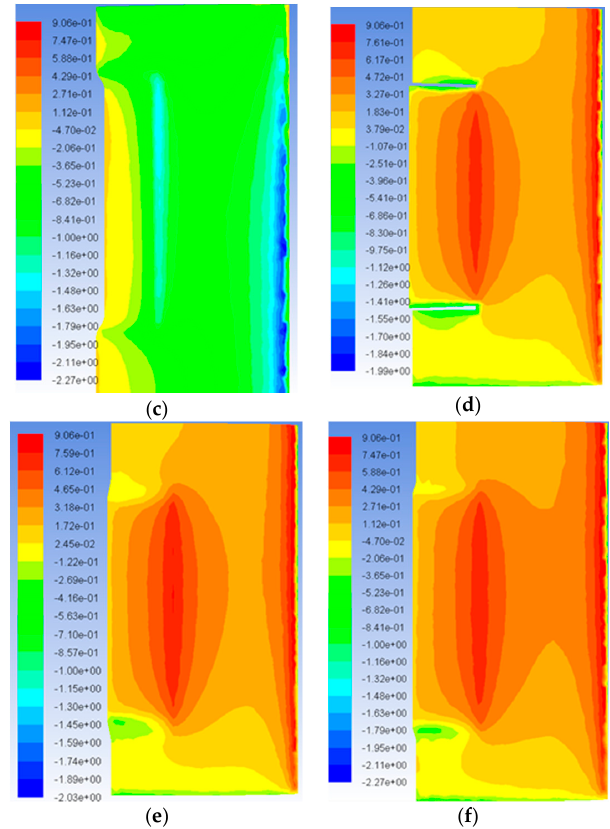
Figure 23. The pressure coefficient distribution ( a ) along the upper surface of the conventional wing; ( b ) along the upper surface of the initial morphing wing; ( c ) along the upper surface of optimized morphing wing; ( d ) along the lower surface of the conventional wing; ( e ) along the lower surface of the initial morphing wing; ( f ) along the lower surface of optimized morphing wing.